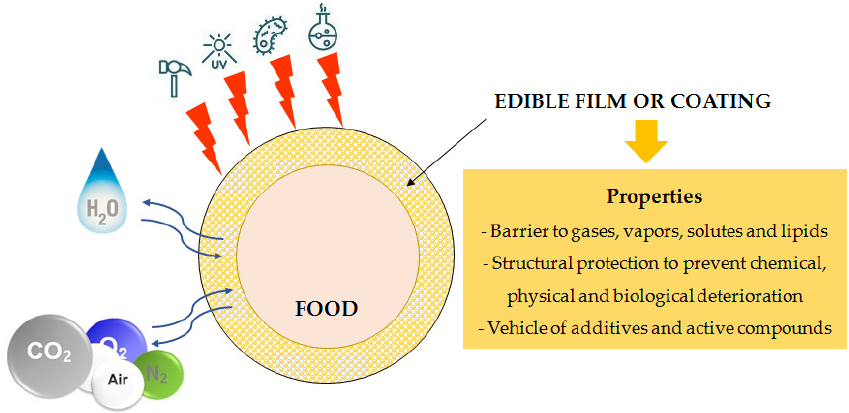
Figure 2. Main functions of edible films and coatings in food packaging applications.